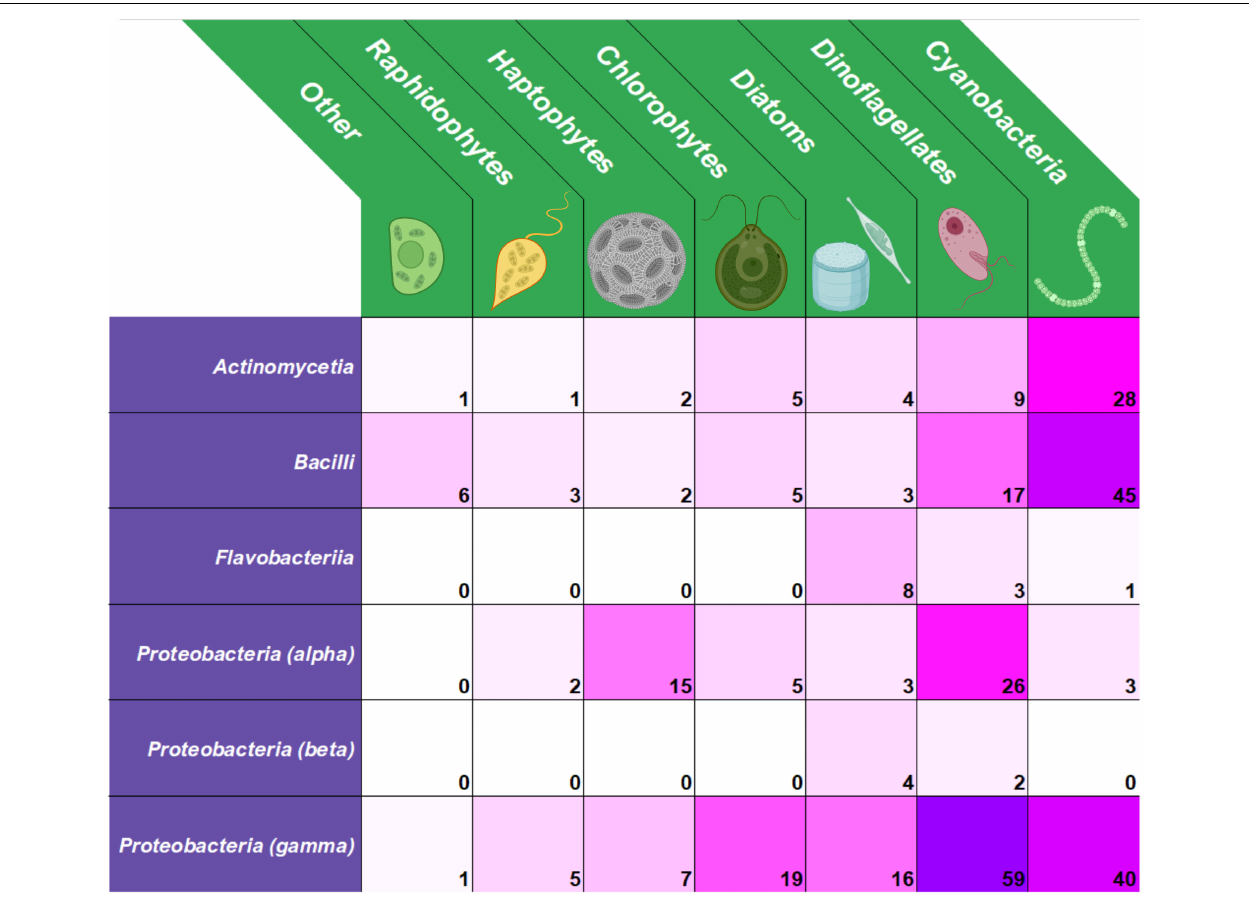
FIGURE 2 | Heatmap of reported interactions between algicidal bacteria (left) and target algal groups (top). Data collected from publications in English dated 2016–2021 ( Supplementary Table 1